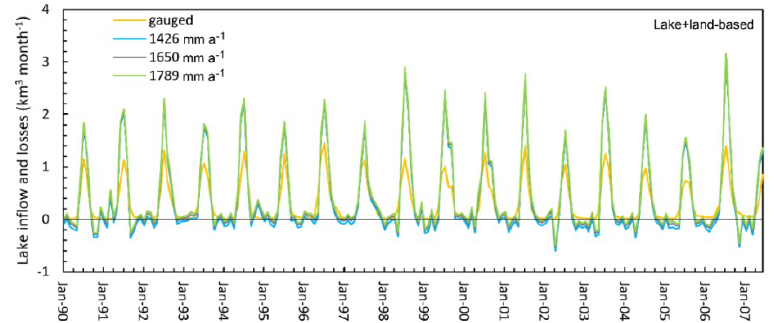
Figure 7. Observed monthly gauged flow of the four major rivers and rate of inflow and losses of Lake Tana calculated with Equation (6) using three evaporation rates 1426, 1650, and 1789 mm a −1 .